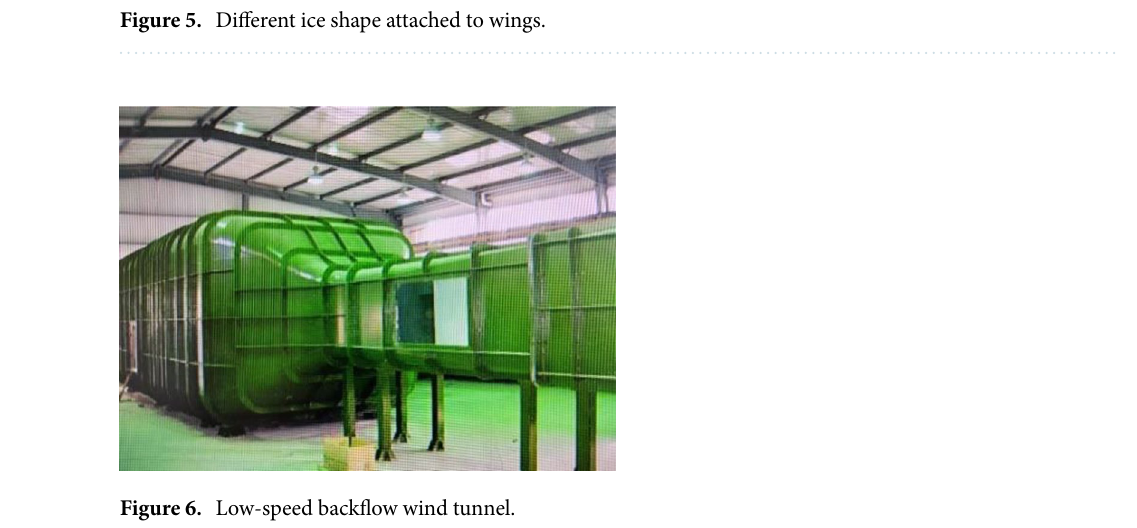
Figure 5. Different ice shape attached to wings.